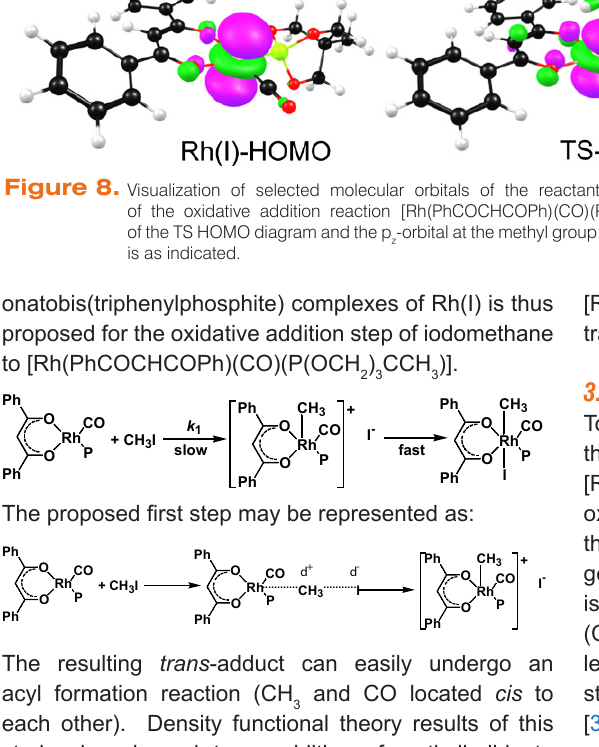
) CCH )] + CH I. Note the d -orbital at the rhodium centre 2 3 3 3 z2